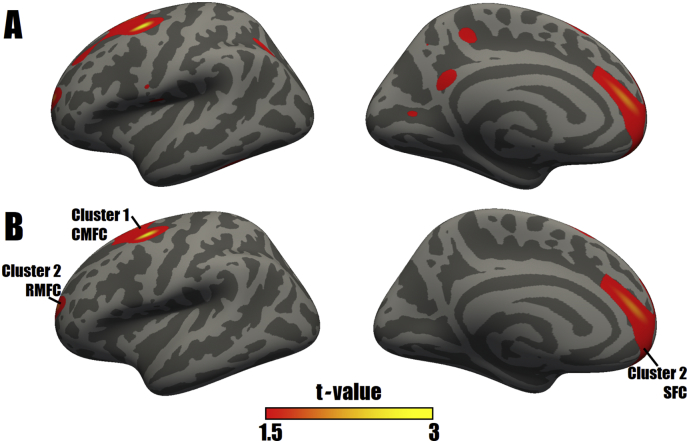
Uncorrected (A) and corrected (B) surface maps of differences in the AIs for cortical thickness between patients with MDD and NCs. As determined by a GLM analysis, differences in AIs are presented on left inflated cortical surfaces. Dark gray indicates gyri; light gray indicates sulci. The color bar represents t values ranging from 1.5 to 3. Red to yellow indicates increased AIs in the MDD group compared with those in the NC group; a closer proximity to yellow indicates a greater difference. The numerals refer to the cluster numbers listed in Table 2. The anatomical locations of the peak vertex of clusters 1 and 2 are the caudal middle frontal cortex (CMFC) and superior frontal cortex (SFC), respectively. Otherwise, the lateral surface of cluster 2 involves a portion of rostral middle frontal cortex (RMFC). (For interpretation of the references to color in this figure legend, the reader is referred to the web version of this article.)